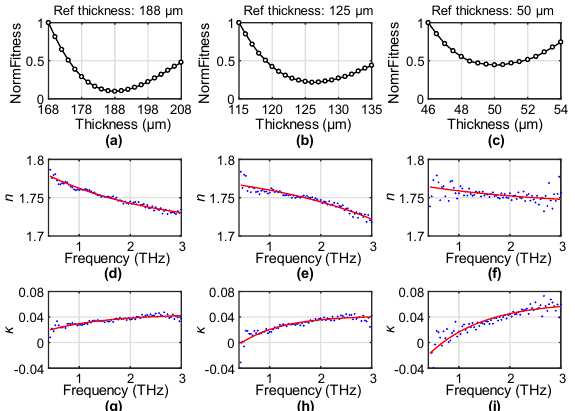
Figure 2. The normalized fitness (NormFitness) of the OE (offset exponential) functions to the extracted n (refractive index) and κ (extinction coefficient) for the ( a ) 188 μm, ( b ) 125 μm , and ( c ) 50 μm PET films. The experimental results of n for the ( d ) 188 μm, ( e ) 125 μm , and ( f ) 50 μm PET films and κ for the ( g ) 188 μm, ( h ) 125 μm , and ( i ) 50 μm PET films at their optimized thicknesses shown in the blue dots, with the red solid curves indicating the OE fitting.